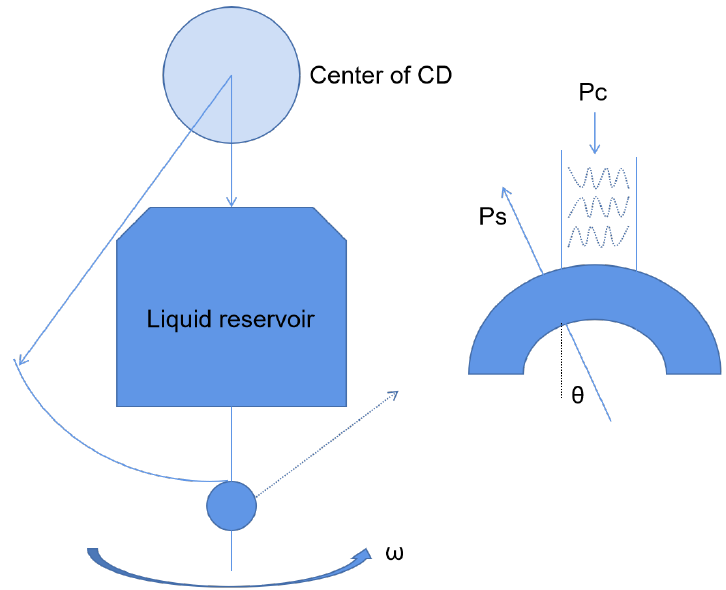
Figure 3. Schematic diagram of the centrifugal chip principle.